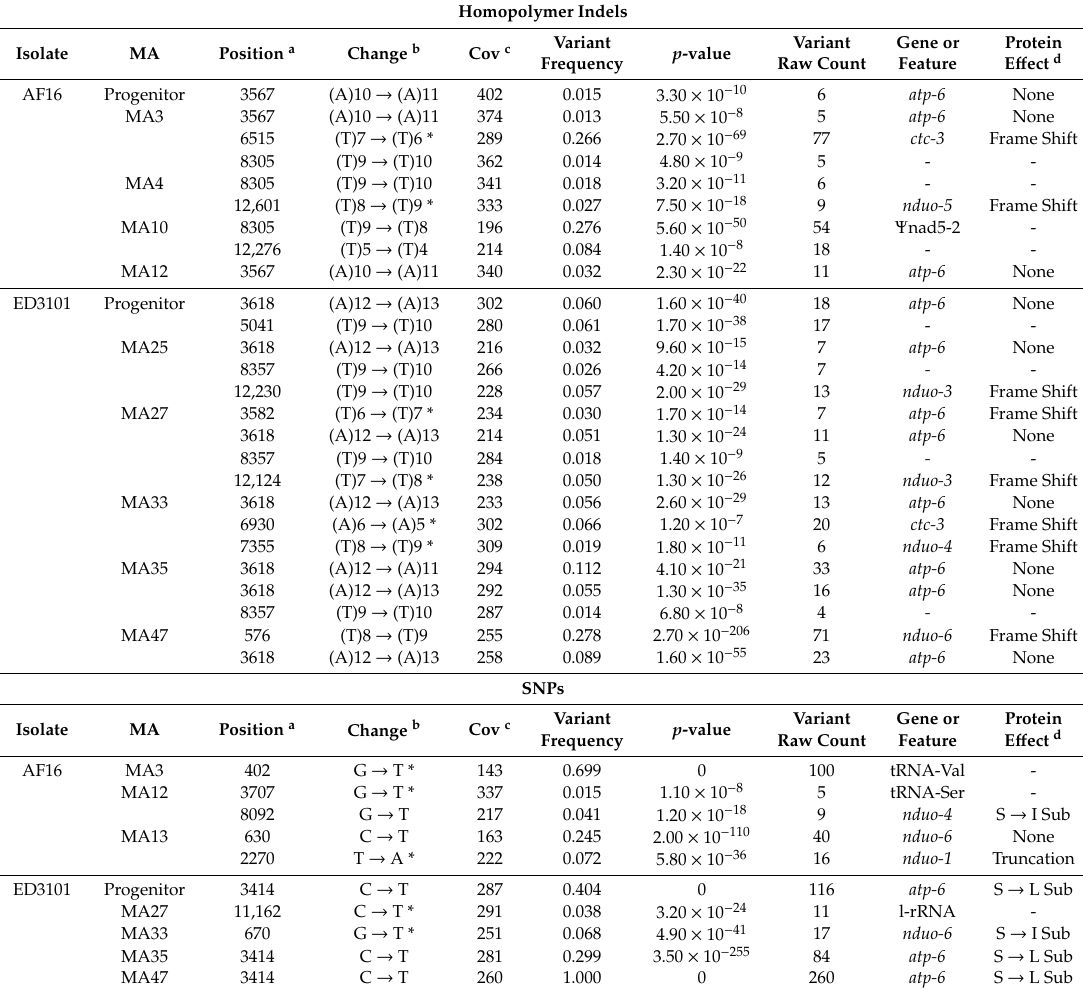
Table 2. Identified homopolymer indels and SNPs in AF16 and ED3101 C. briggsae MA lines.